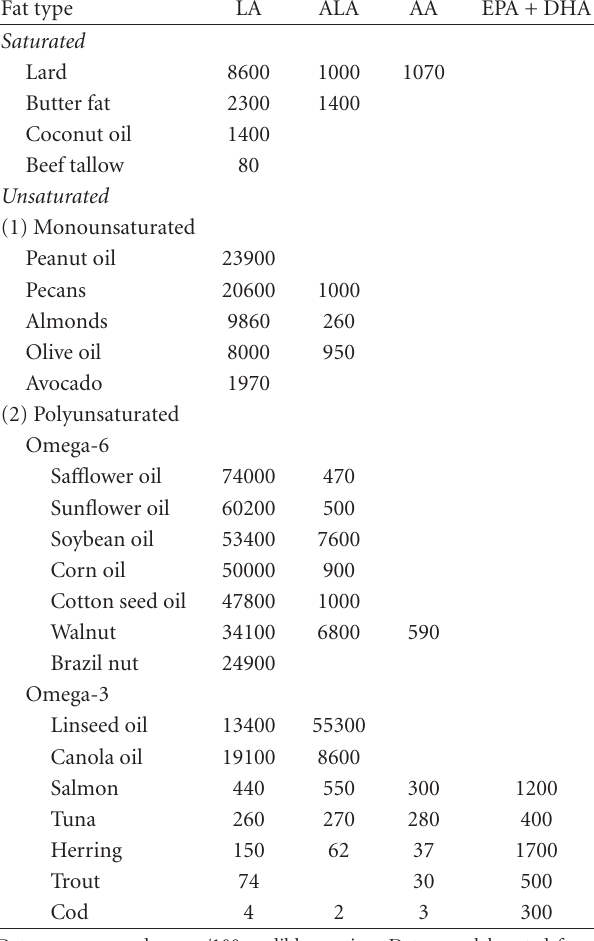
Table 1: PUFA content of dietary